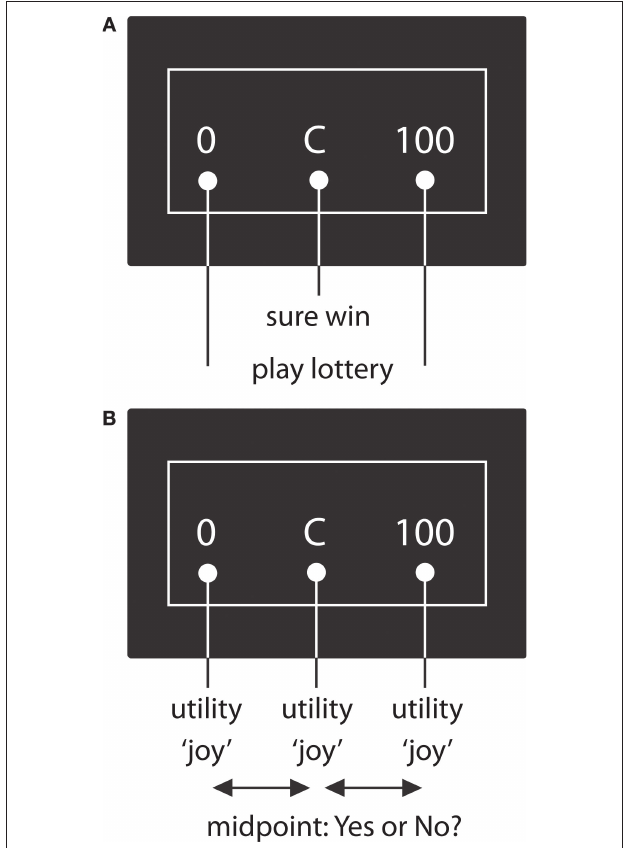
FIGURE 1 | Prototypical decision task for the binary lottery (A) and the bisection task (B).